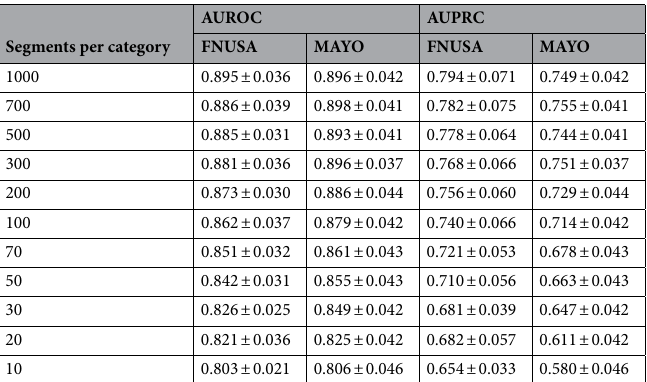
Table 4. Description of cross-validation results for FNUSA and MAYO datasets. The table shows area under receiver operating curve (AUROC) and area under precision-recall curve (AUPRC).